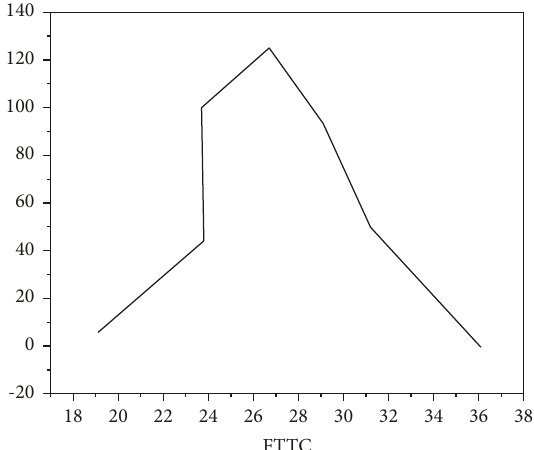
Figure 7: Evaluation of ROS production performance of IrOX@ DOX at the cell